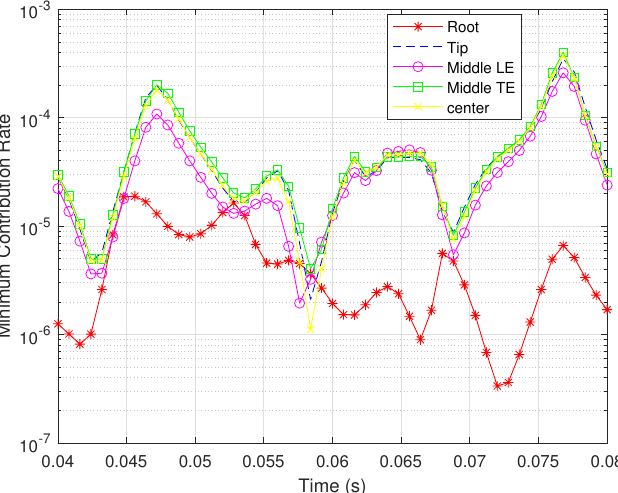
Figure 11. Minimum contribution rates for shear strain sensors located in different places.